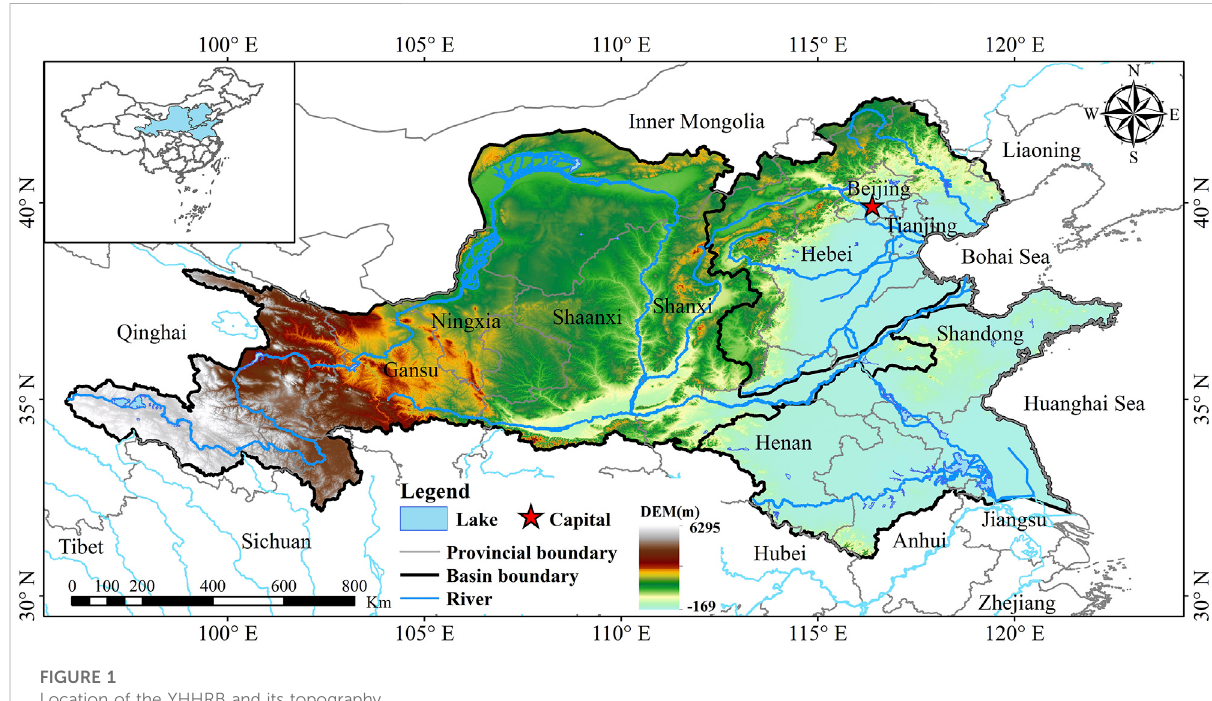
FIGURE 1 Location of the YHHRB and its